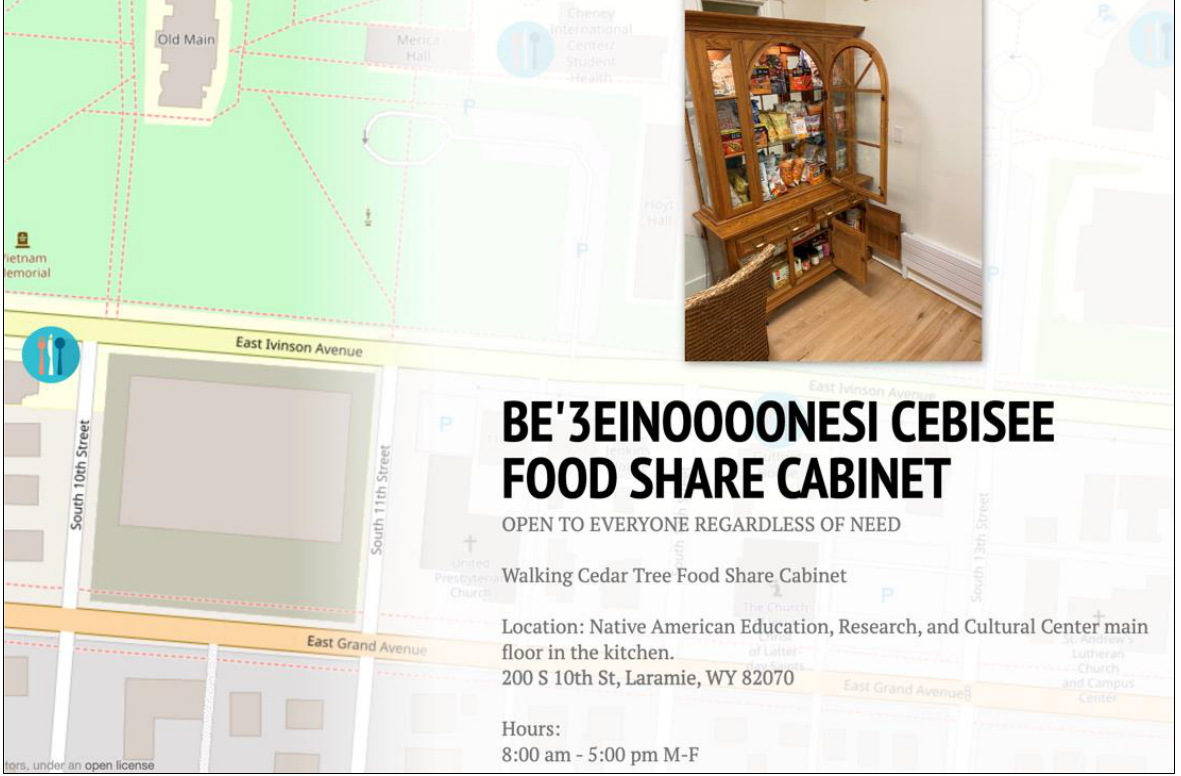
Image courtesy of Every Poke Nourished,